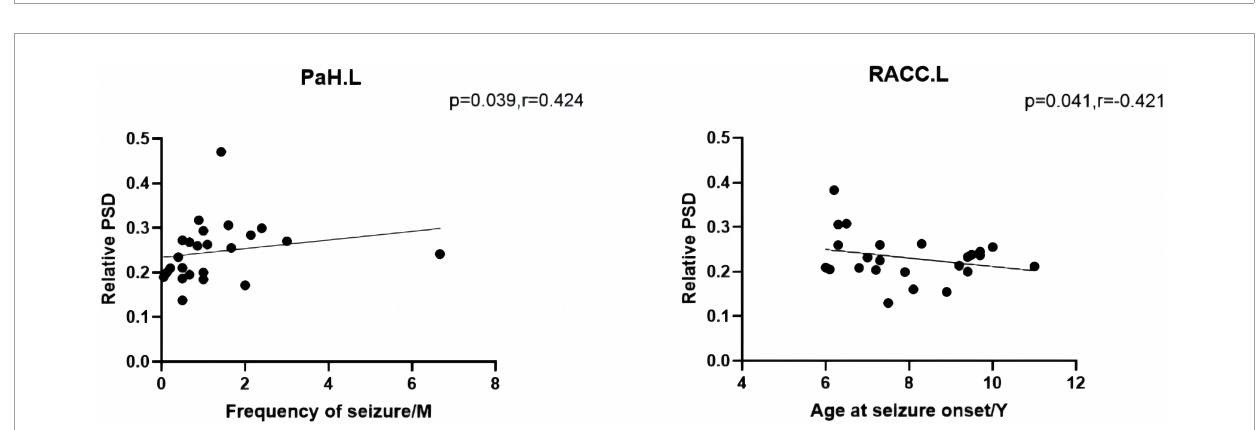
FIGURE5 The left shows that the frequency of seizure of the CNI group was negatively associated with relative spectral power in the theta band. The right shows that the age at seizure onset of the CI group was positively associated with relative spectral power in the theta band. M, months, Y, years, PSD, relative power spectral density. * p < 0.05 after FDR multiple